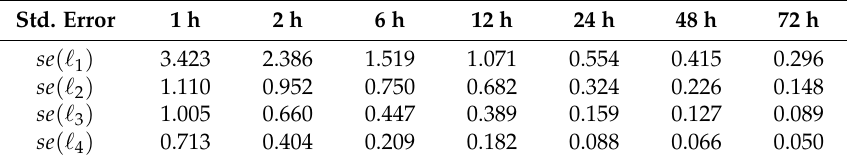
Table 3. Standard errors (in mm/h) of sample L-moments of rainfall intensity data.